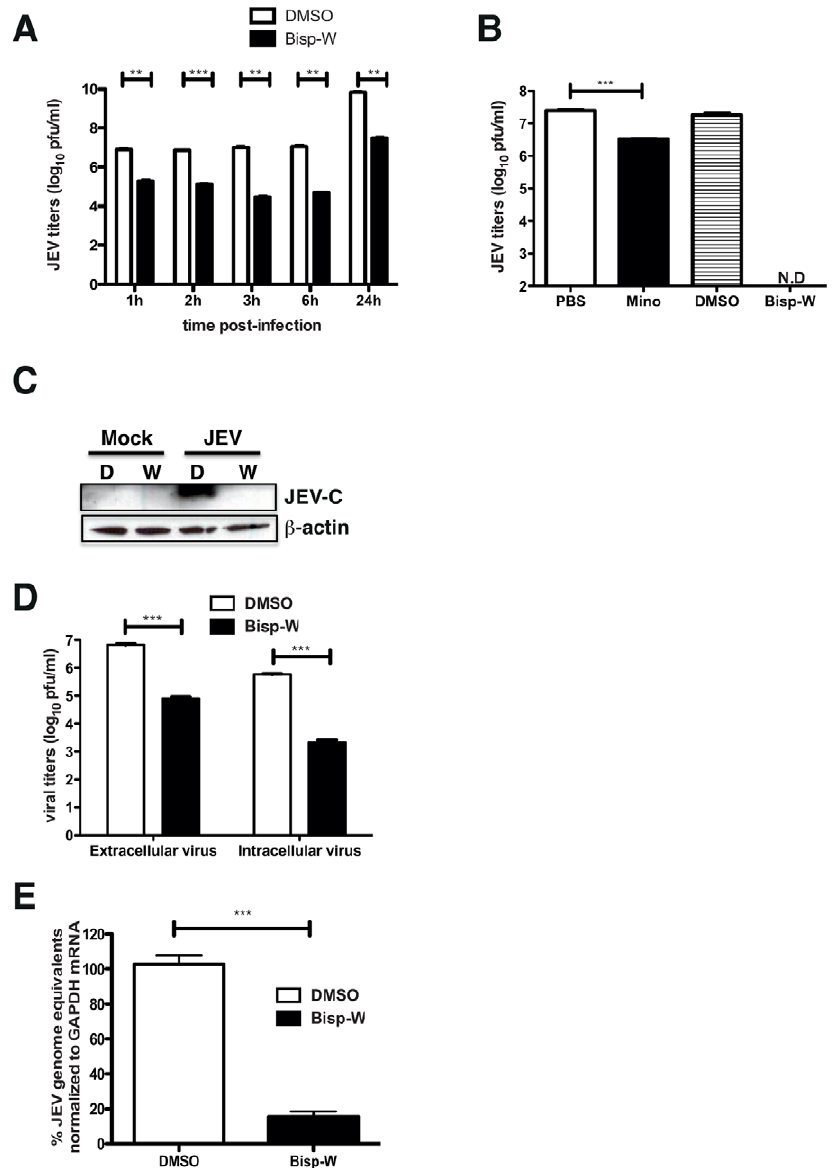
Figure 5. Bisp-W blocks JEV RNA replication. (A) Viral titers were determined by plaque assay of N2A cell culture supernatants (22 h pi) infected with JEV and treated with DMSO or 5 m M of Bisp-W at the indicated time points. Error bars represent Mean 6 SEM. ** P , 0.005, **** , 0001, * , 0.01, ** 0.096 and ** , 0.001 for respective time points. (B) Viral titers were determined by plaque assay of N2A cell culture supernatants infected with JEV and treated with PBS or 20 m M minocycline and DMSO or 5 m M of Bisp-W as described in materials and methods. Error bars represent Mean 6 SEM. *** P=0.0002. N.D: Not Detected. (C) Western blot analysis of N2A lysates prepared from JEV-infected and DMSO or Bisp-W-treated cells. C- Capsid. b – actin is shown for loading control. (D) Viral titers were determined from supernatants (extracellular) and cell lysates (intracellular) at 22 h pi by plaque assay of samples from N2A cells infected with JEV and treated with 5 m M of Bisp-W at 1 h post-infection. ***P=0003 and 0.00002 respectively. (E) Total RNA was isolated from N2A cells infected with JEV and treated with 5 m M Bisp-W at 1 h post-infection. JEV genome copy numbers were estimated by quantitative real time PCR normalized to GAPDH mRNA. ** P=0.0001 by unpaired two-tailed t-test. Error bars represent Mean 6 SEM. Data are representative of two or more experiments performed with three